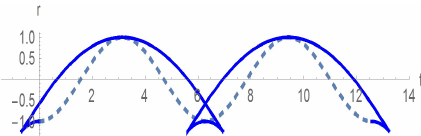
Figure 8. The parametric curve (Eqs. 27 and 28) with Br = 2 (the solid curve) in comparison with the linear problem with Br = 0 (the dashed line).